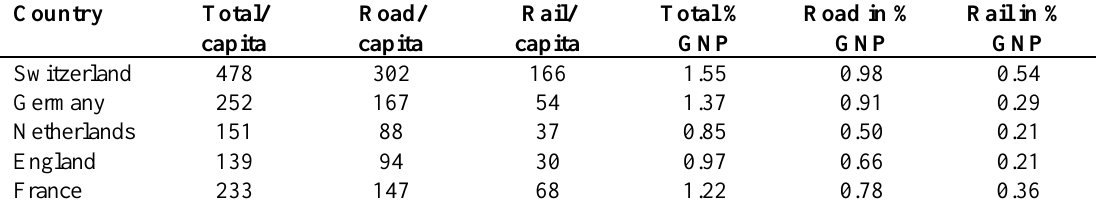
Table 11. Infrastructure expenditure (1993), including maintenance (1994